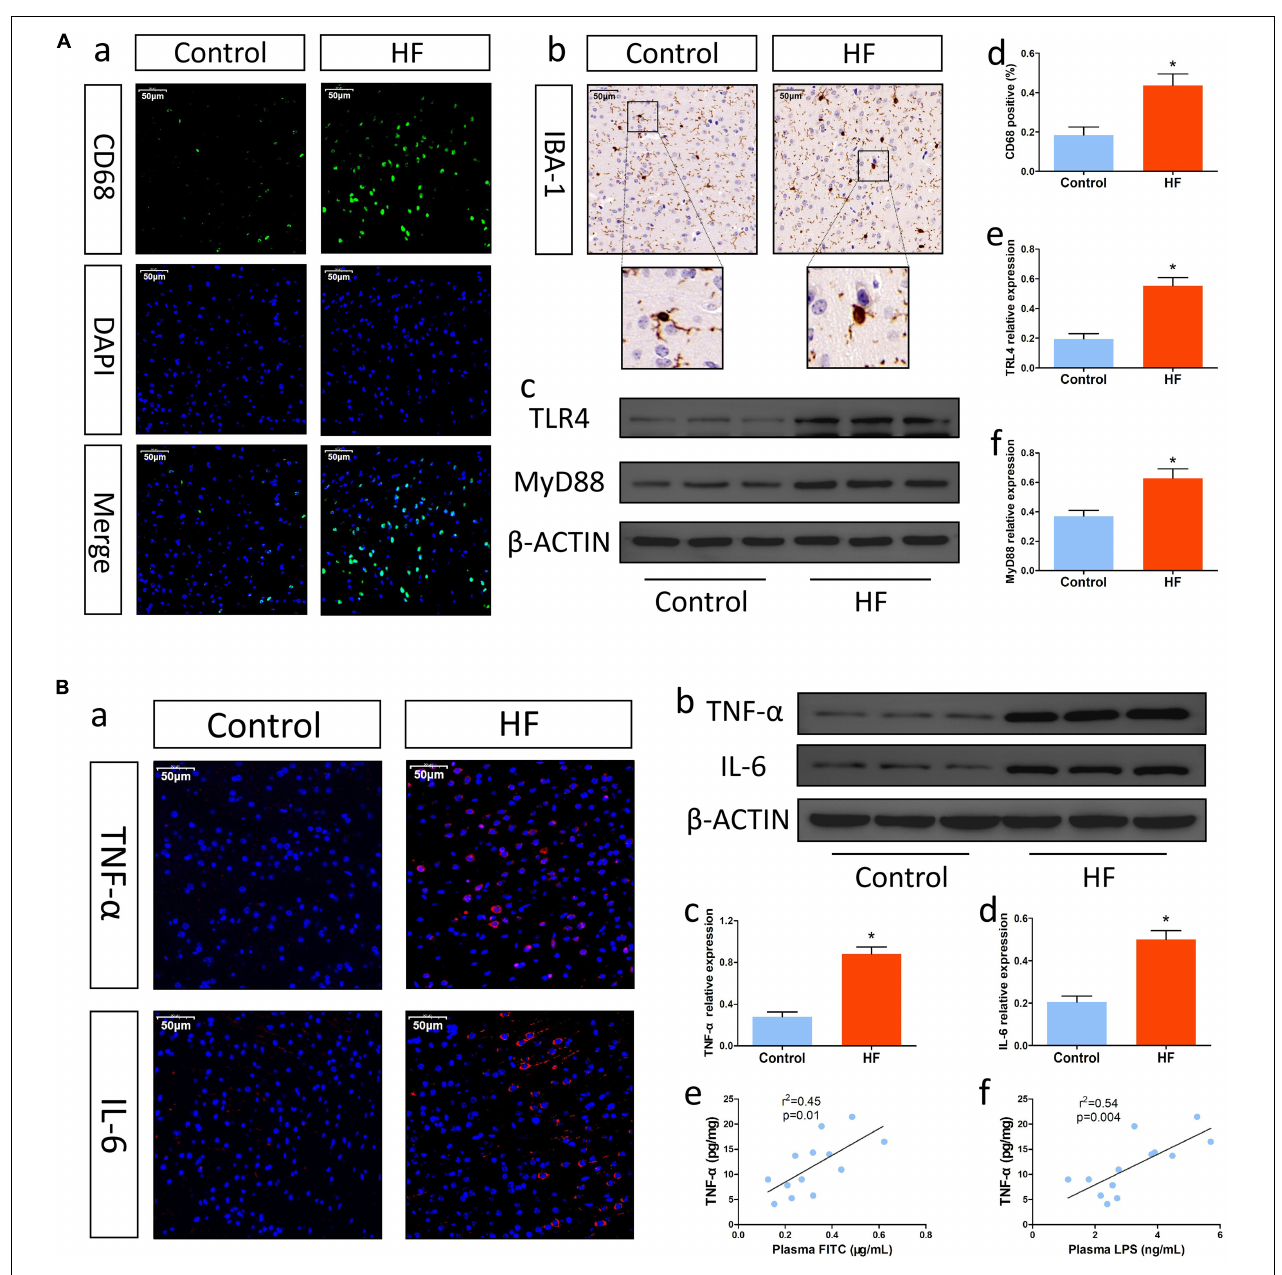
FIGURE 2 | Changes in neuroinflammation after HF. (A) Changes in inflammatory cells and the proinflammatory pathway in brain tissue after HF. (a) Representative immunofluorescent images of anti-CD68 staining (magnification, 400 × ) in the brains of mice. (b) Representative immunohistochemical images of Iba-1 expression (magnification, 400 × ) in the brains of mice. (c) Western blot analysis of the relative levels of TLR4, MyD88 and the control β -actin in brain tissue. (d) Quantitative analysis of CD68-positive microglia in the brain. (e,f) Quantitative analysis of TLR4 and MyD88 expression. (B) Alterations in inflammatory cytokines in brain tissue after HF. (a) Immunofluorescence analysis of TNF- α and IL-6 expression (magnification, 400 × ) in the brains of mice. (b) Western blot analysis of the relative levels of TNF- α , IL-6 and the control β -actin in brain tissue. (c,d) Quantitative analysis of TNF- α and IL-6 expression. (e) Correlation analysis of brain TNF- α levels and plasma FITC-dextran concentrations. (f) Correlation analysis of brain TNF- α levels and plasma LPS levels. * P < 0.05 vs. the control group. Iba-1, ionized calcium binding adaptor molecule-1; TLR4, Toll-like receptor 4; MyD88, myeloid differentiation factor 88; LPS,